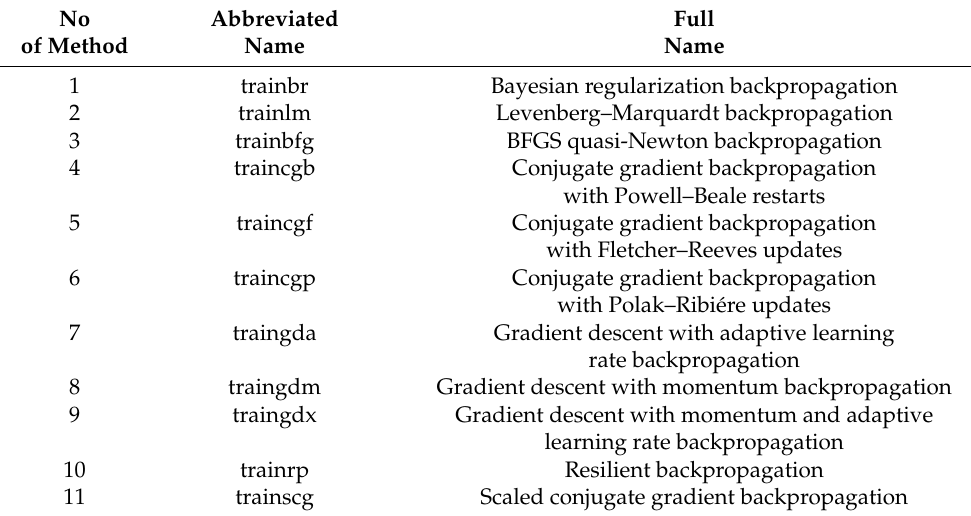
Table 1. The abbreviated and full names of the learning methods for ANNs.